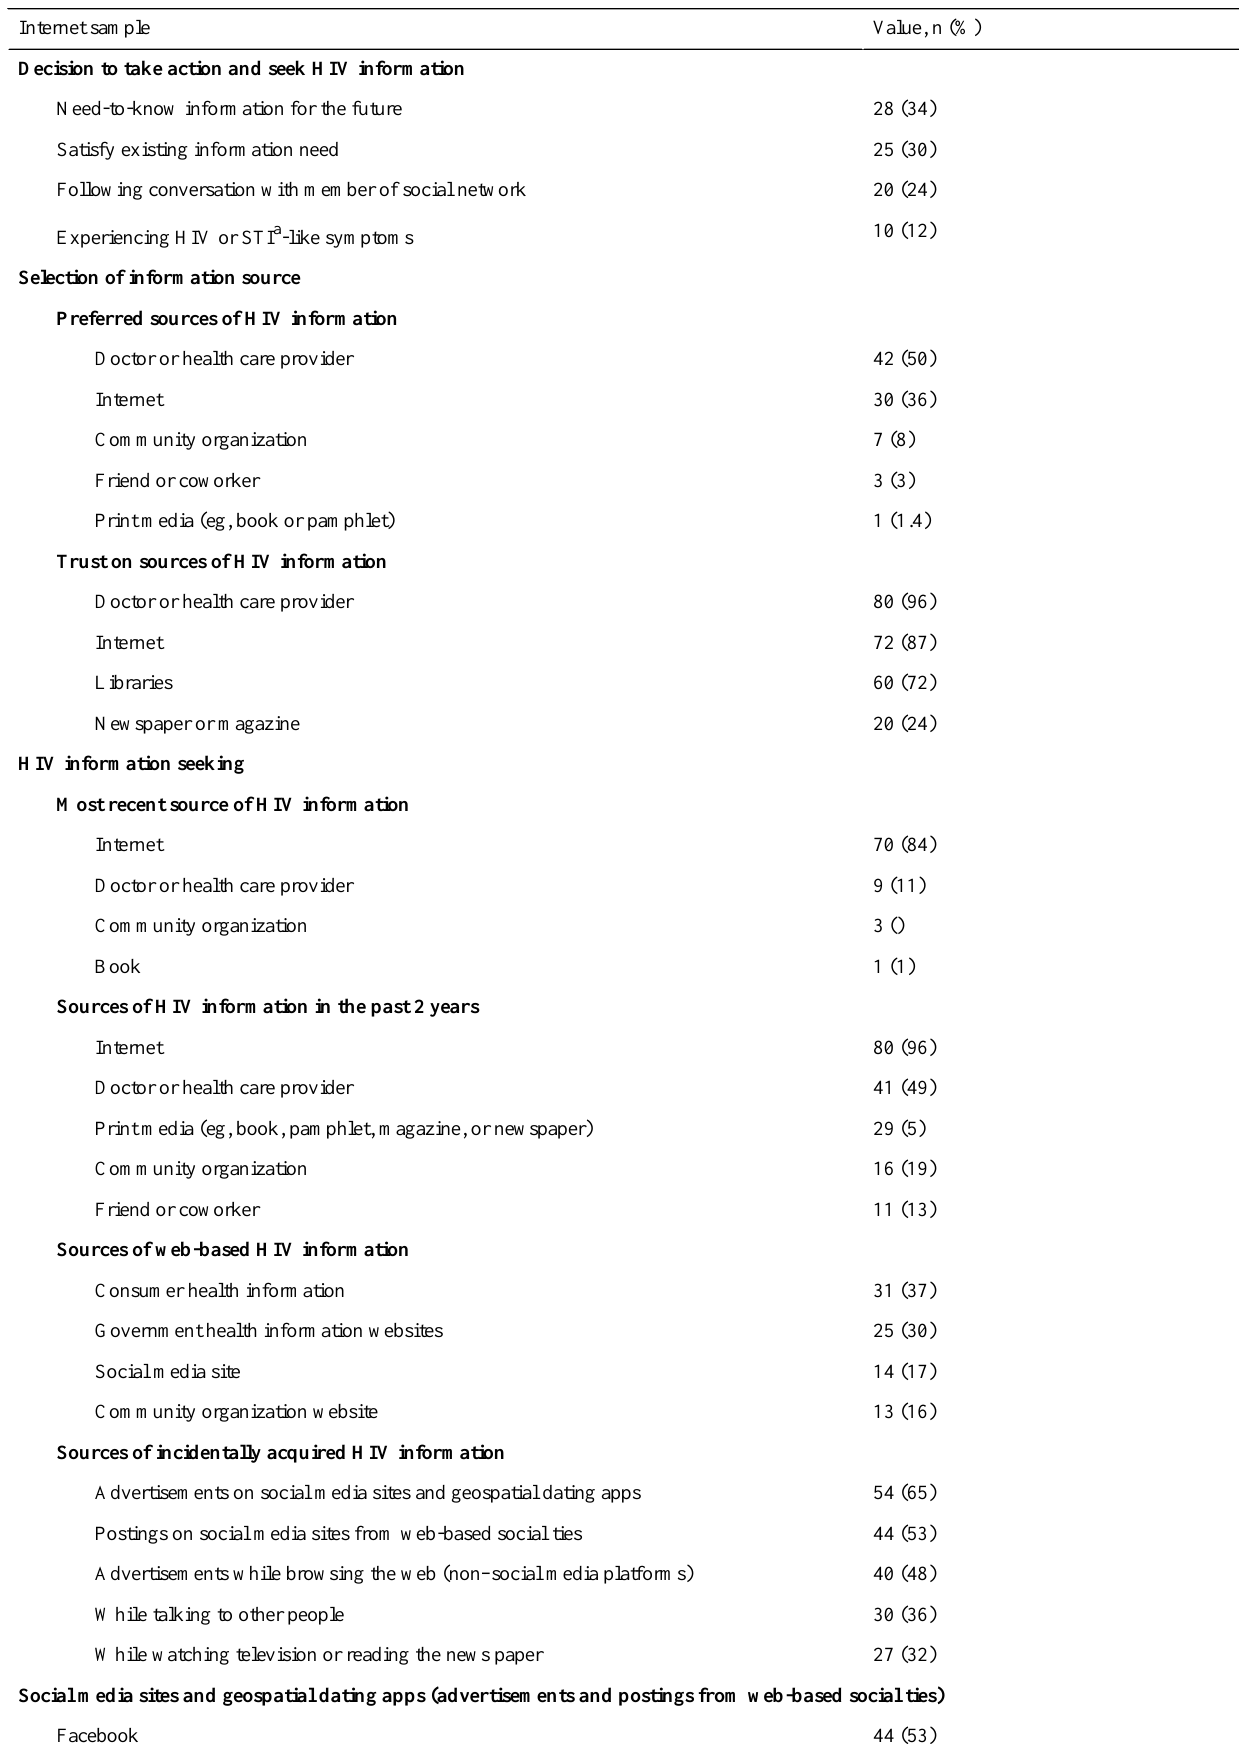
Table 3. HIV information acquisition and use—internet sample